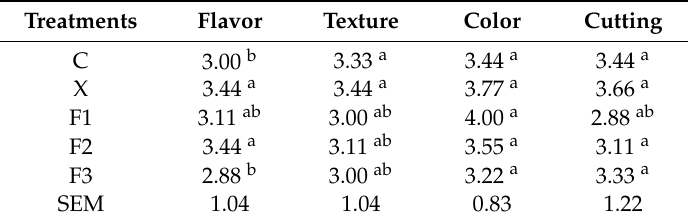
Table 3. Sensory scores in Cheddar cheese samples after 90 days of